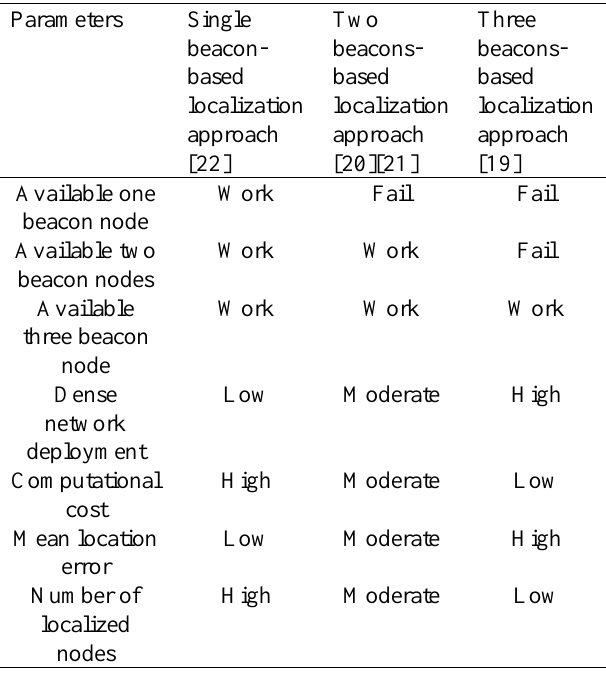
Table 1. Taxonomy of beacon-based localization approaches for sensor nodes in WSN Parameters Single Three beacons- based based localization localization localization approach [20][21]